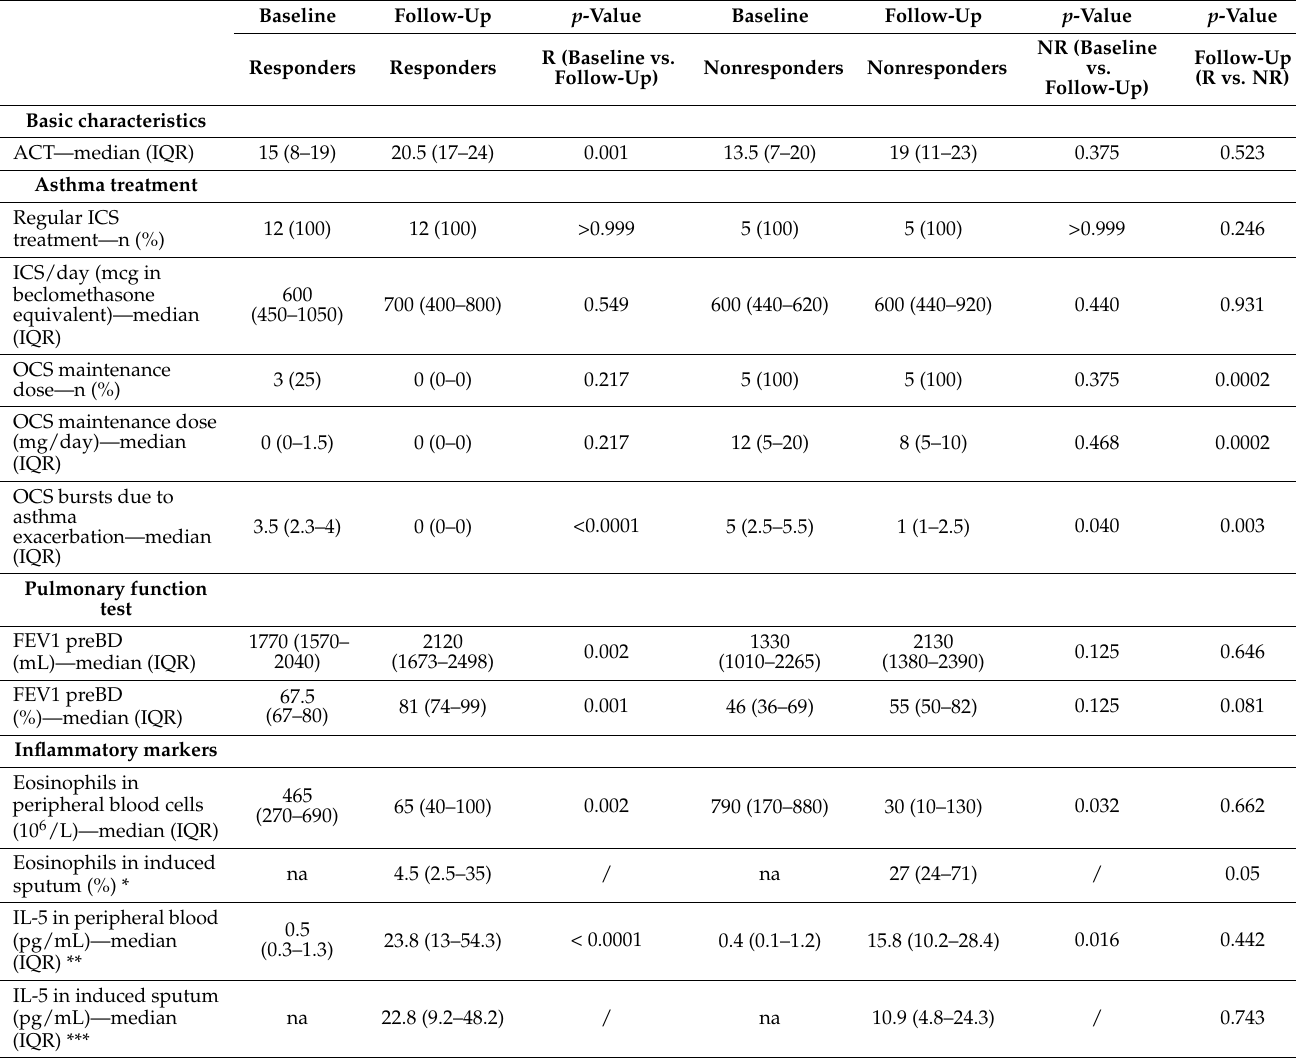
Table 2. Comparison of baseline and follow-up